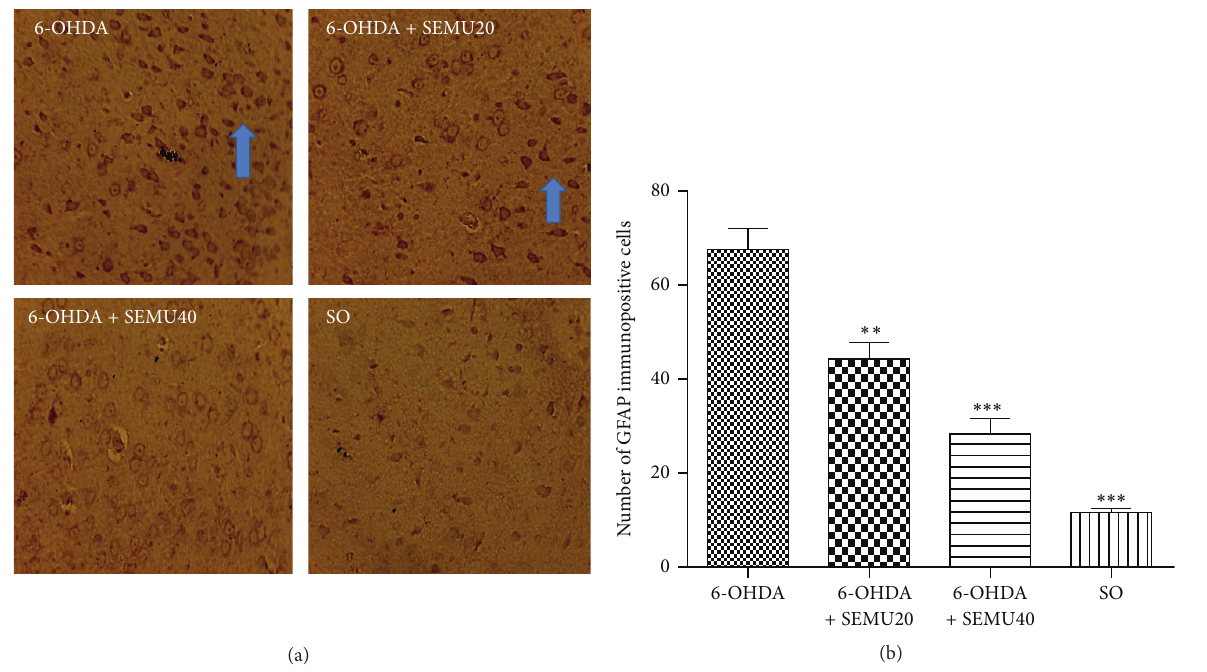
Figure 6: Immunohistochemistry for GFAP (a marker for astrocytes), in the lesioned right striatum (a). A high number of immunopositive cells are present in the untreated 6-OHDA group, and this number decreased in the 6-OHDA group after SEMU treatments (20 and 40 mg/kg, p.o.). Almost no immunopositive cells were noticed in the SO group (magnification: 400x). Arrows indicate GFAP immunopositive cells. (b) shows the means ± SEM of the number of GFAP immunopositive cells (three different fields) in each group. ∗∗∗ versus the untreated 6-OHDA group ( F = 52.80, 𝑃 < 0.0001